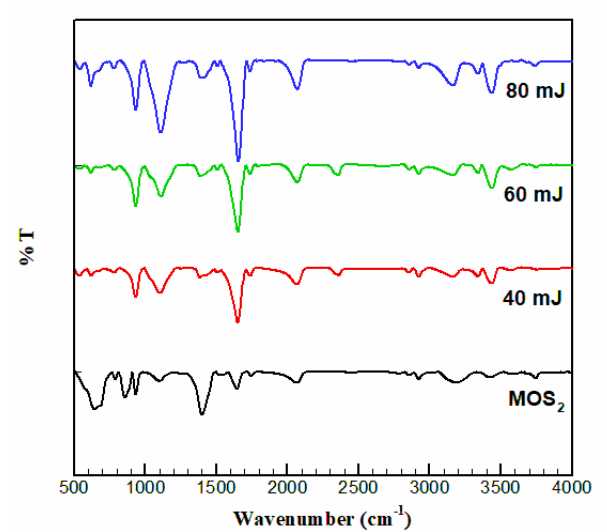
Figure 2. X-ray diffraction (XRD) pattern of the MoS 2 structures under various laser energies from 40 to 80 mJ.